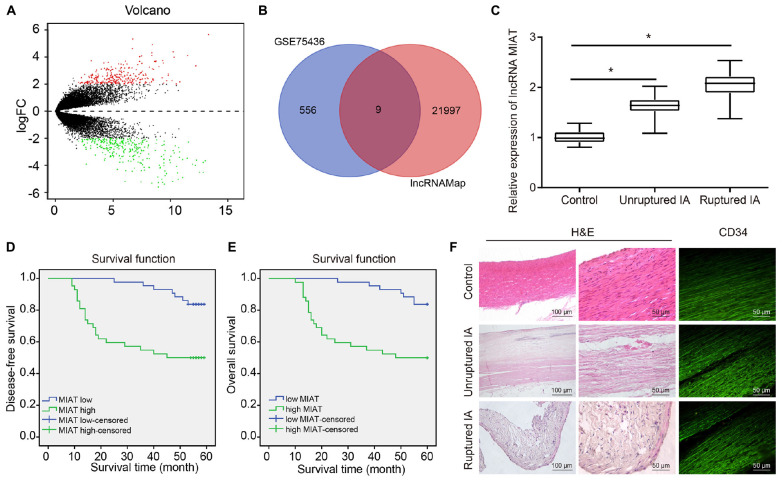
The high expression of MIAT and damaged endothelial cell continuity are observed in patients with IA. (A) The volcano plot of GSE75436 analyzed by R language. Red dots represented the upregulated genes, and green dots represented the downregulated genes (LogFC > 2, p < 0.01). (B) The Venn diagram of the differentially expressed lncRNAs in GSE75436 and the total lncRNAs obtained from lncMAP, and the intersections included lncRNA SFTA1P, CTD-2165H16.3, NAPSB, RP3-525N10.2, CTB-12O2.1, FLVCR2, EMX2OS, EGFEM1P, and MIAT. (C) The expression of MIAT in ruptured IA, unruptured IA, and control samples determined by RT-qPCR. (D) The correlation between the expression of MIAT and disease-free survival of patients with IA. (E) The correlation between the expression of MIAT and overall survival of patients with IA. (F) The HE staining (×100, ×200) for carotid arteries near branch or IA lesions, and immunofluorescence staining (×200) for vascular endothelial cells labeled with CD34 antibody. *p < 0.05 vs. the control samples. The measurement data were expressed as mean ± standard derivation. Comparisons between two groups were analyzed by unpaired t test, while the correlation between the expression of MIAT in patients with IA and their disease-free survival and overall survival was analyzed by Kaplan–Meier method (long-rank test).